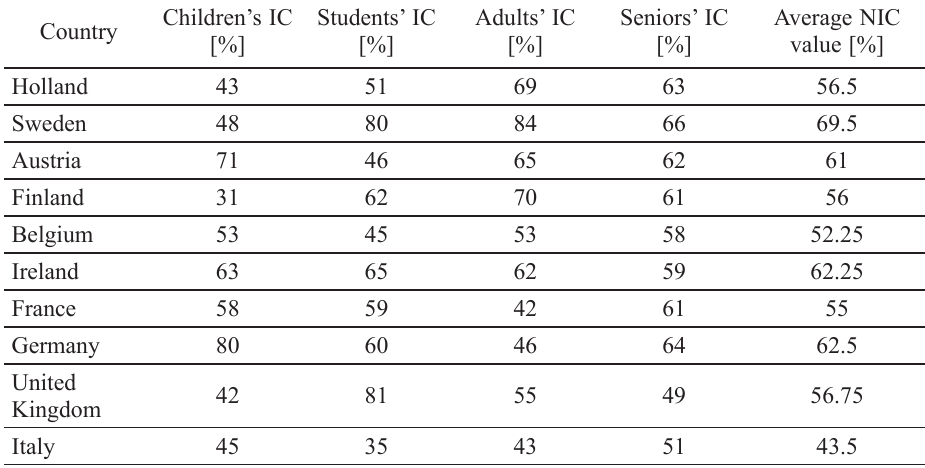
Table 1. Values of intellectual capital for particular generational